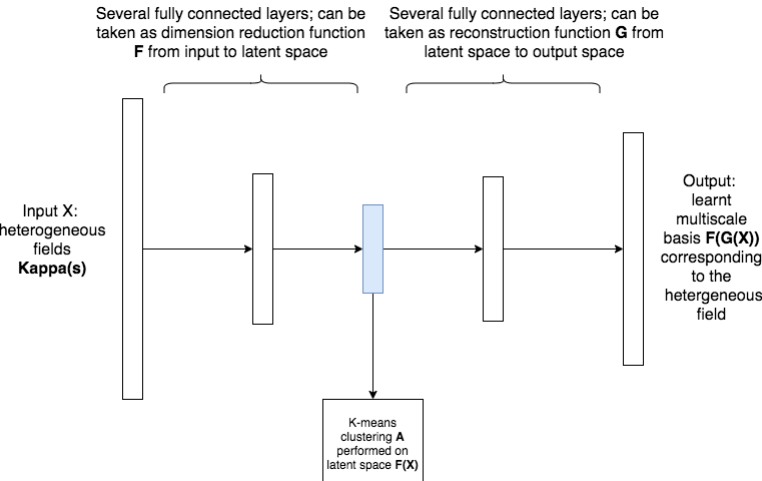
Figure 4. Cluster